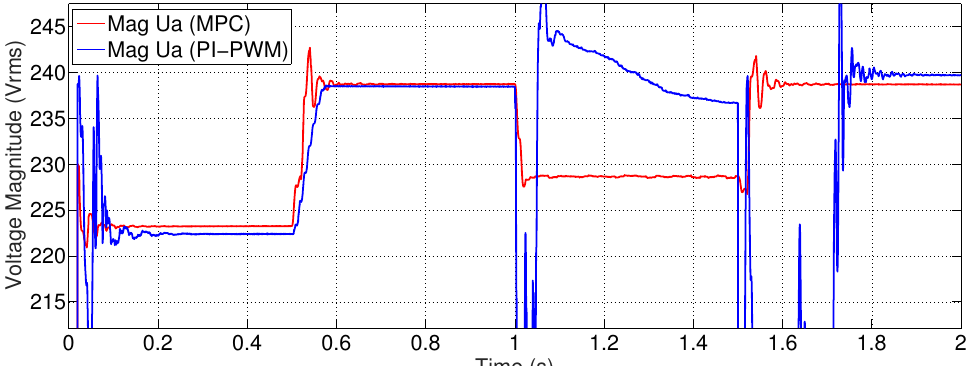
Figure 4. Comparison of the THD values for the current exchange with the main grid between the MPC and PI-PWM Controllers.